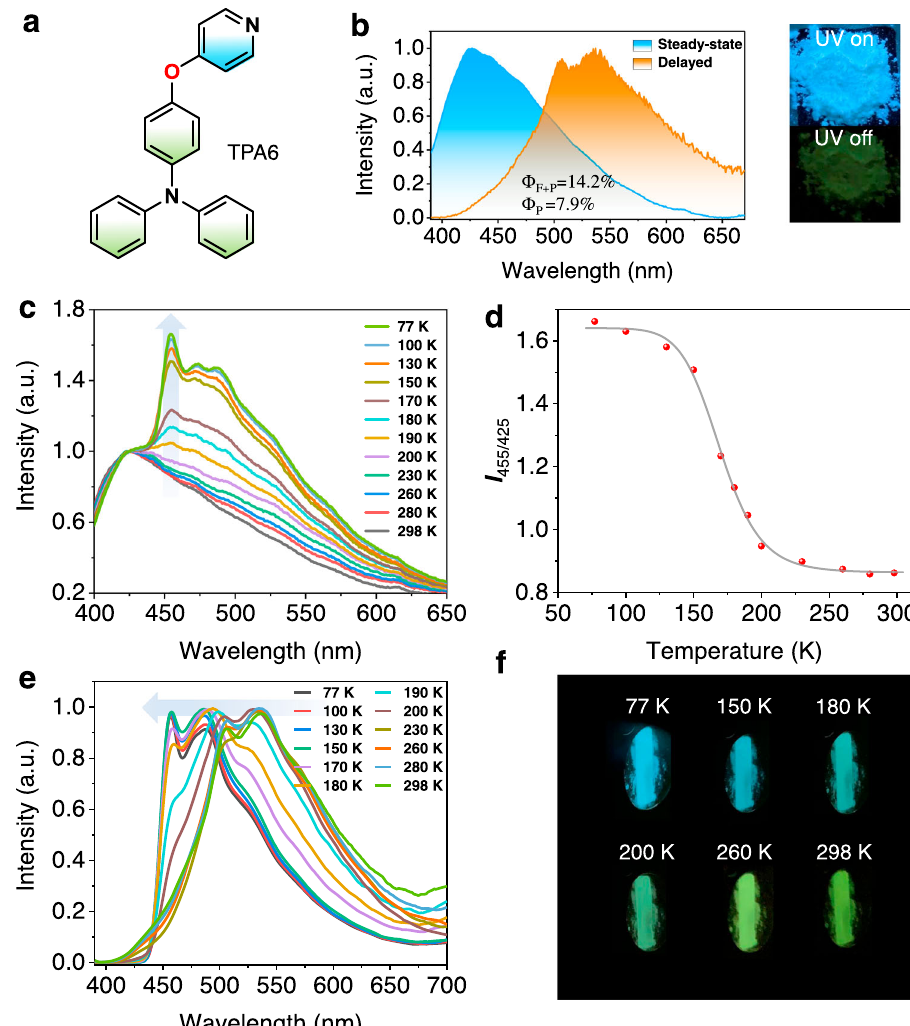
Fig. 7 Photophysical properties of TPA6. a Chemical structure of TPA6. b Normalized steady-state and RTP emission ( Δ t = 3 ms) spectra of TPA6 in air at room temperature; inset: photo showing TPA6 solid excited by 365-nm UV light. c Relative steady-state emission spectra of TPA6 at different temperatures. d Relationship between the emission intensity ratio of 455 and 425 nm ( I 455 / I 425 ) and temperature. e Normalized temperature-dependent phosphorescence emission spectra of TPA6. f Image showing delayed emission (>50 ms) color change at different